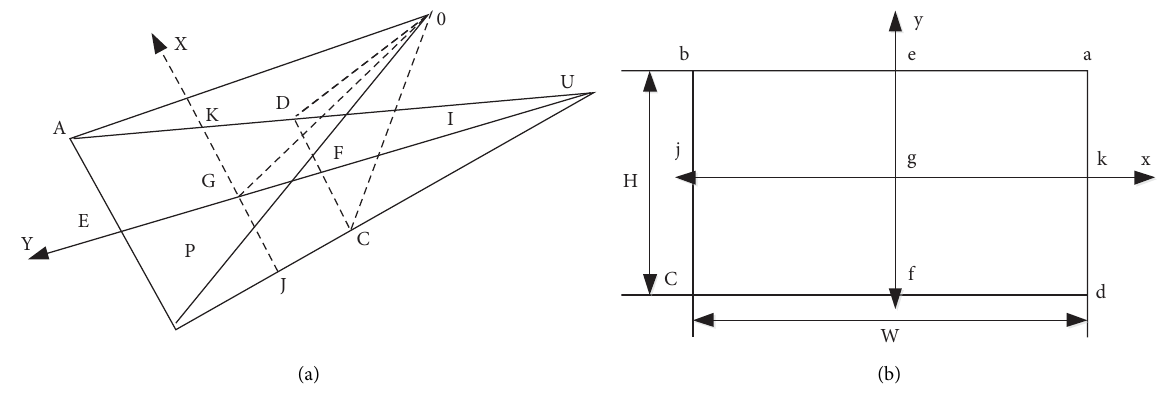
Figure 1: Ground projection model and camera image